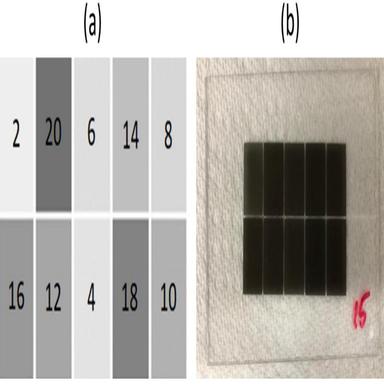
(a). Ten rectangle image stack design where numbers indicate the instances of UV light being projected on each rectangle, i.e., from left to right and top to bottom, 2, 20, 6, 14, 8, 16, 12, 4, 18, 10; (b) Photo of printed file on an acrylic sheet for thickness characterization.